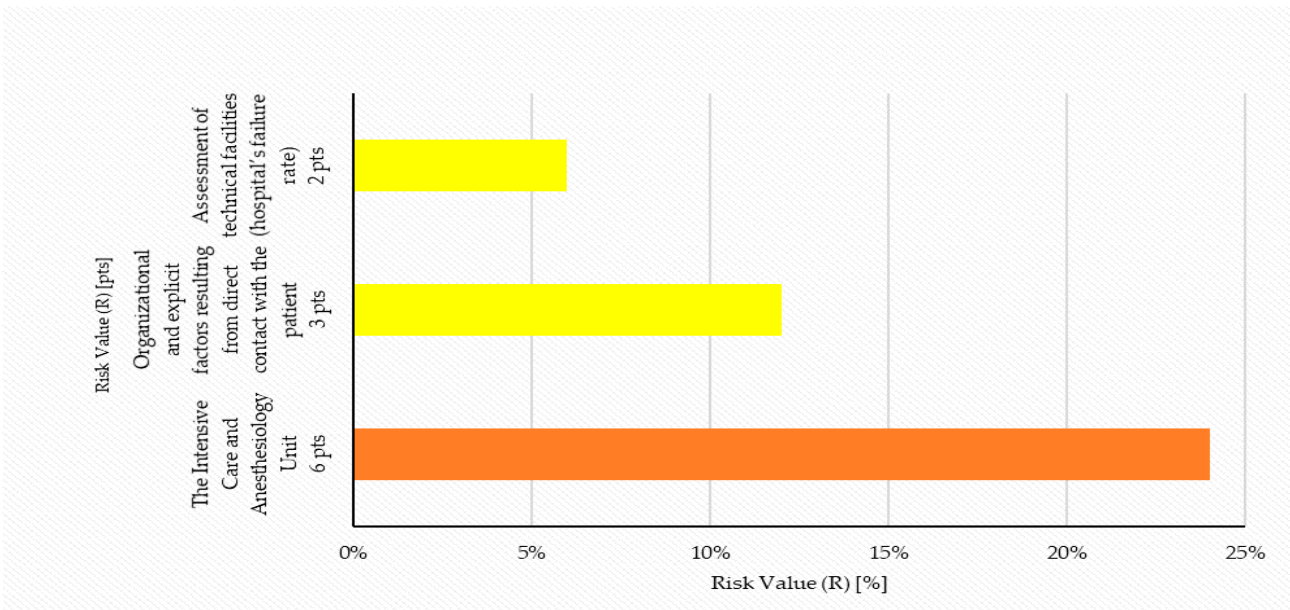
Figure 4. Potential risk or exposure for the hospitalized patient that may be caused the Intensive Care and Anesthesiology Unit, technical facilities (hospital’s failure rate) as well as organizational factors and explicit factors resulting from direct contact with the patient. factors and explicit factors resulting from direct contact with the